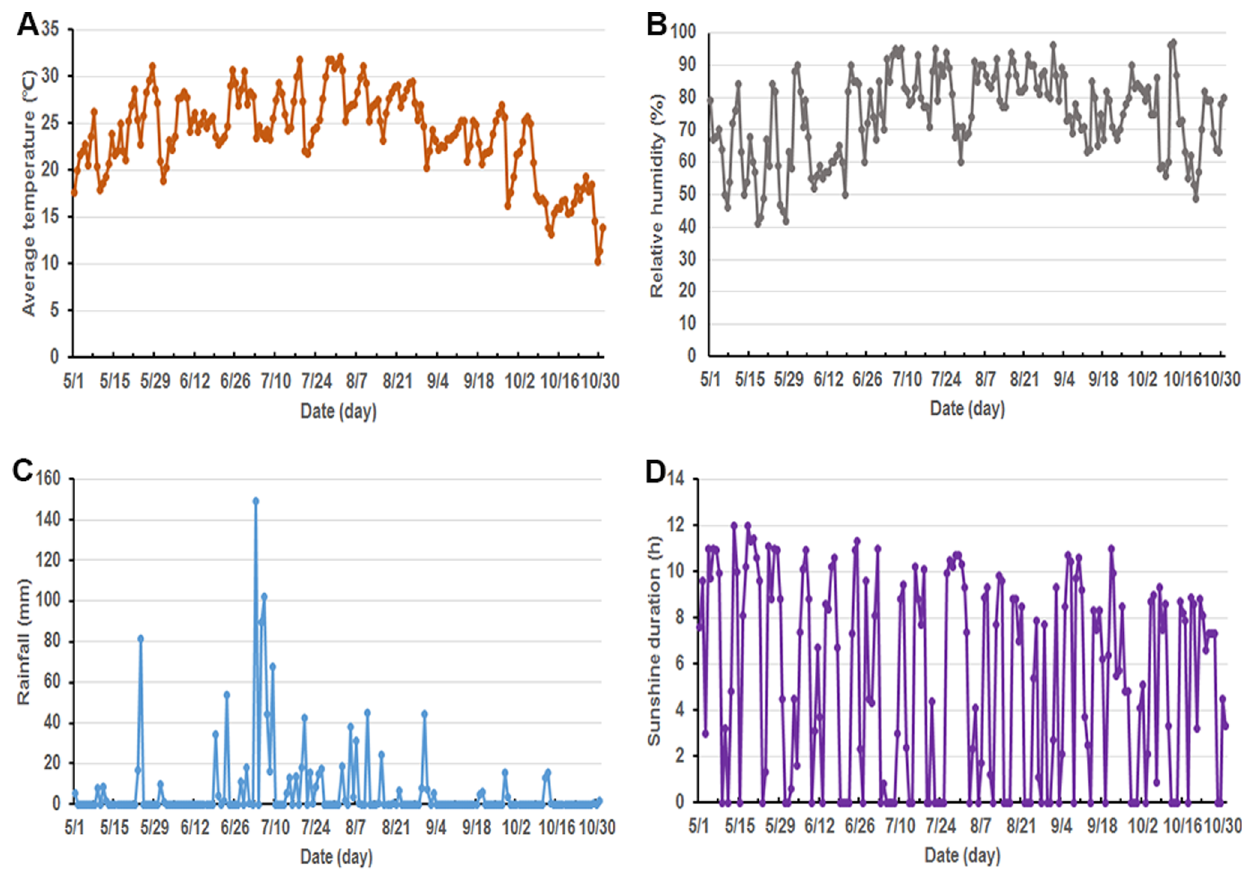
Figure 3. The distribution of daily meteorological factors during the study period. (A) Daily average temperature in Mengcheng County; (B) daily average relative humidity in Mengcheng County; (C) daily rainfall in Mengcheng County; (D) daily sunshine duration in Mengcheng County.